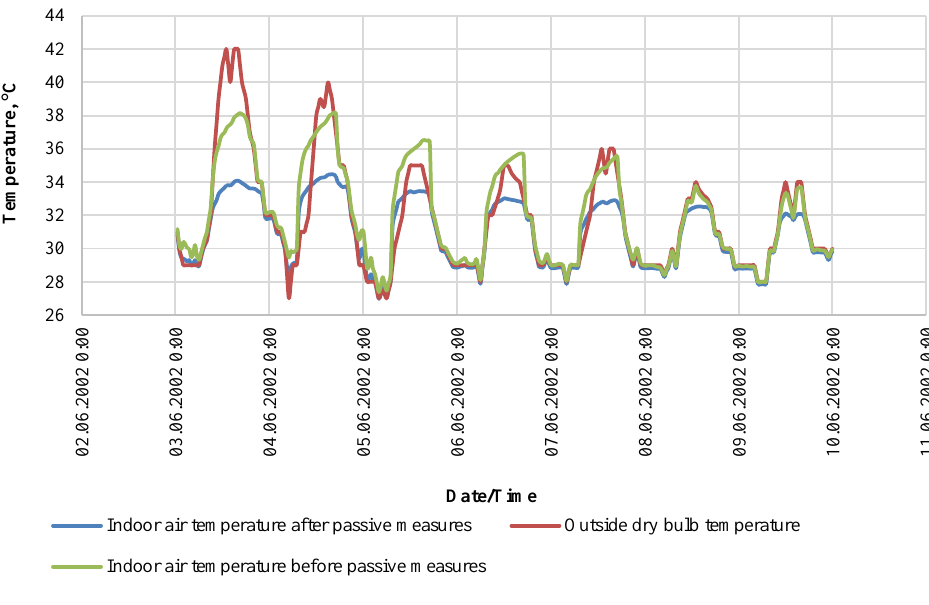
Fig. 12. Comparison of indoor air temperature improvement before and after passive measures.